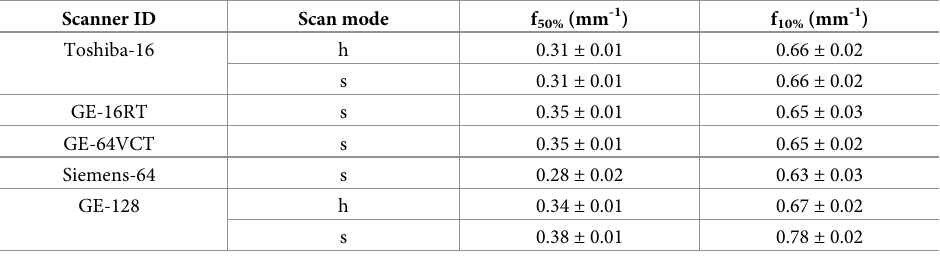
Table 7. Spatial frequencies (mean ± standard deviation across five repeated measurements) corresponding to 50% (f 50% ) and 10% (f 10% ) of the MTF curves, for each CT scanner/acquisition protocol.